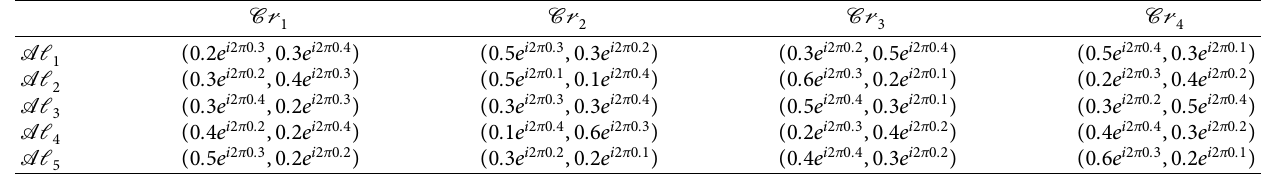
Table 3: Complex intuitionistic fuzzy decision matrix Ὤ ( 3 ) � [ L ( 3 ) Cr 1